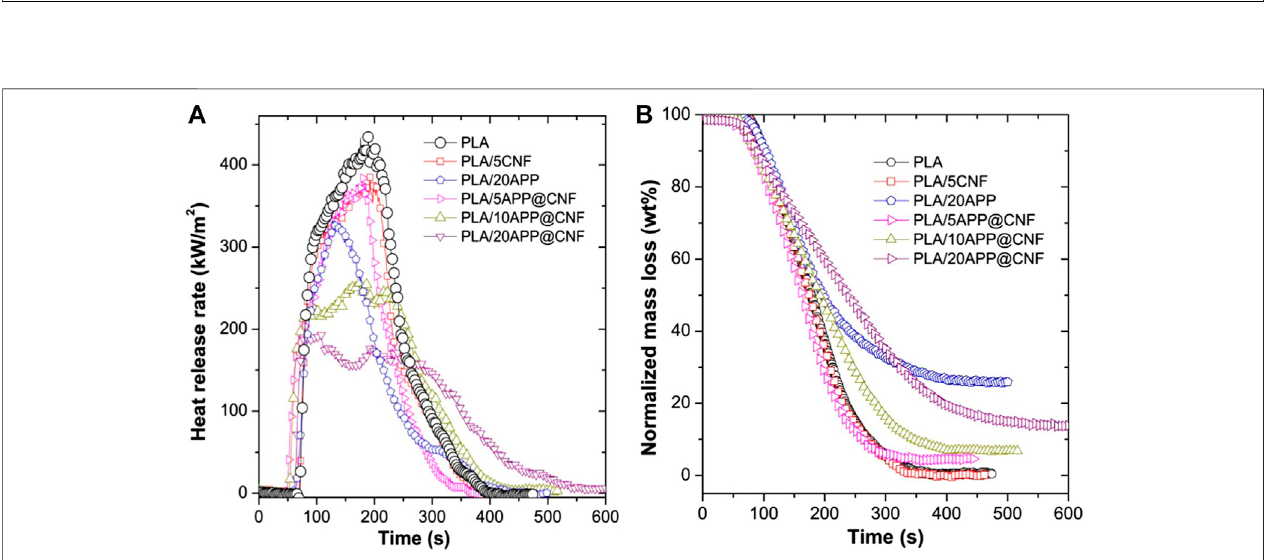
FIGURE11|(A) HRRand (B) masslosscurvesofPLAbiocompositesobtainedfromconecalorimetertestswithanexternalheat fl uxof35 kW/m 2 (Yinetal.,2018).